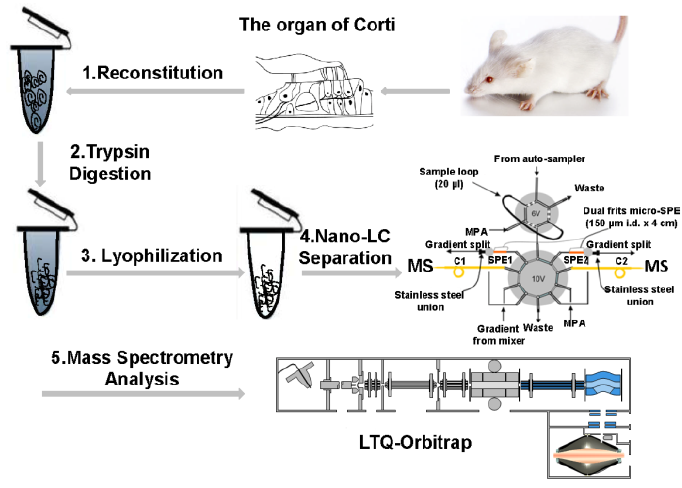
Figure 2. Schematic diagram of proteomic analysis of the mouse organ of Corti (OC) sample. ( 1 ) The OCs were reconstituted in 100 µL lysis buffer (100 mM ammonium bicarbonate, pH 8.4); ( 2 ) The lysates were reduced by 5 mM DL-Dithiothreitol (DTT) and digested by trypsin overnight; ( 3 ) The digests were desalted and dried in a vacuum centrifuge immediately after digestion; ( 4 ) Dried peptides were subjected to the in-house assembled reverse phase metal-free multiple-column nanoLC system coupled with ( 5 ) LTQ-Orbitrap XL mass spectrometer for MS analysis.